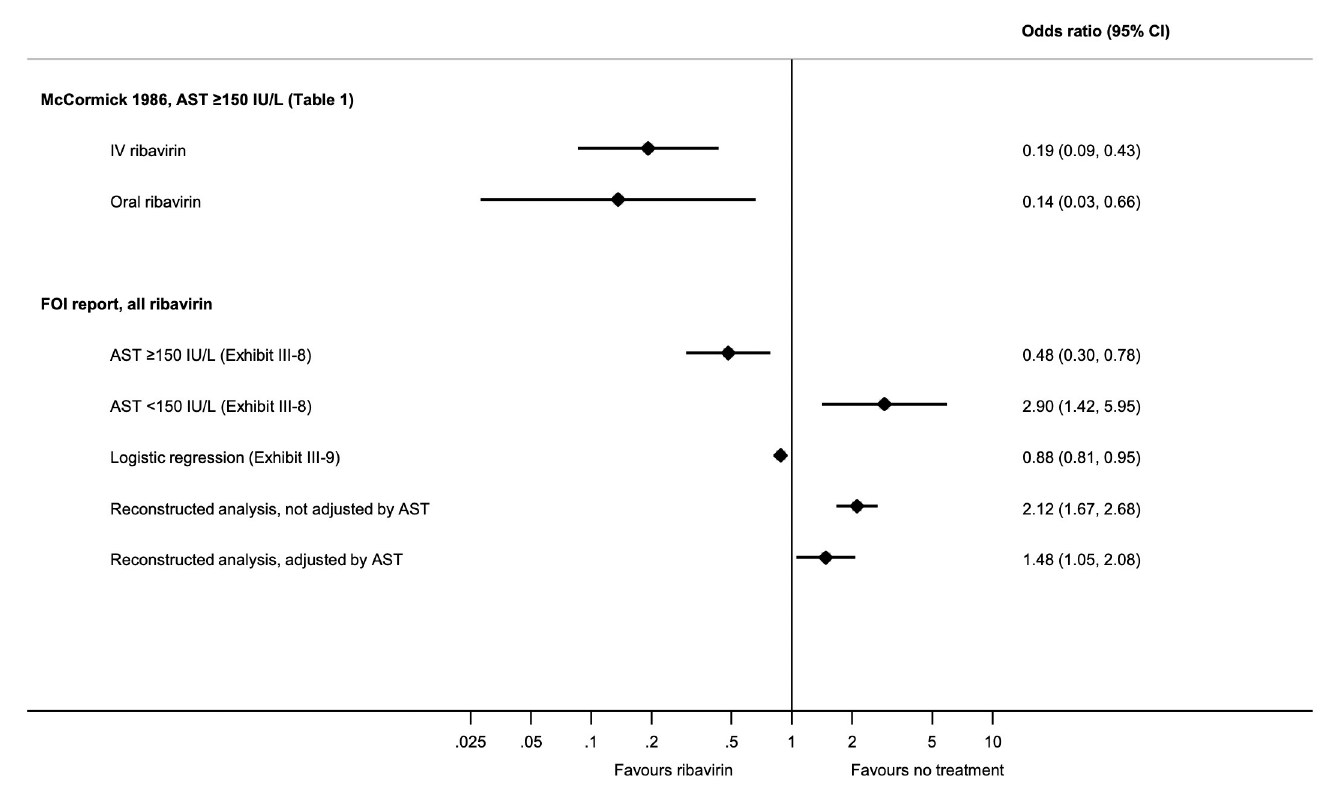
Fig 2. Forest plot of the OR of death in treatment and risk subgroups. AST, aspartate aminotransferase; FOI, freedom of information; OR, odds ratio.